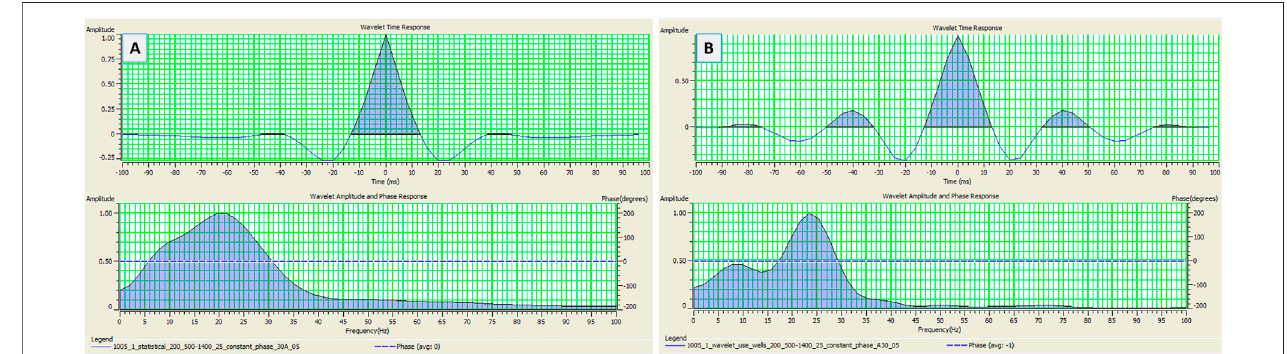
Frontiers in Energy Research |